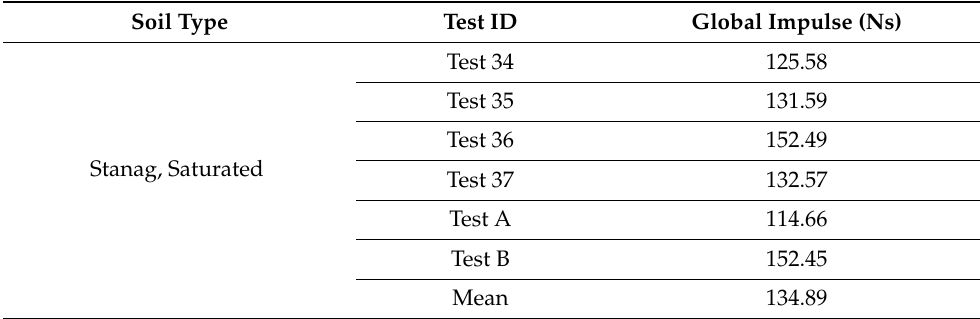
Table 4. Global impulse derived from integration of pressure over a 0.7 ms truncation time for an area-limited interpolation between HPBs (from